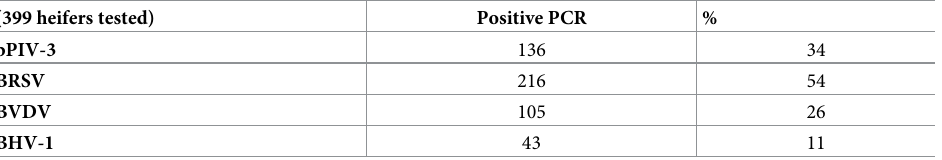
Table 6. Frequency of viral multiplex PCR from nasal secretions collected at 1 st